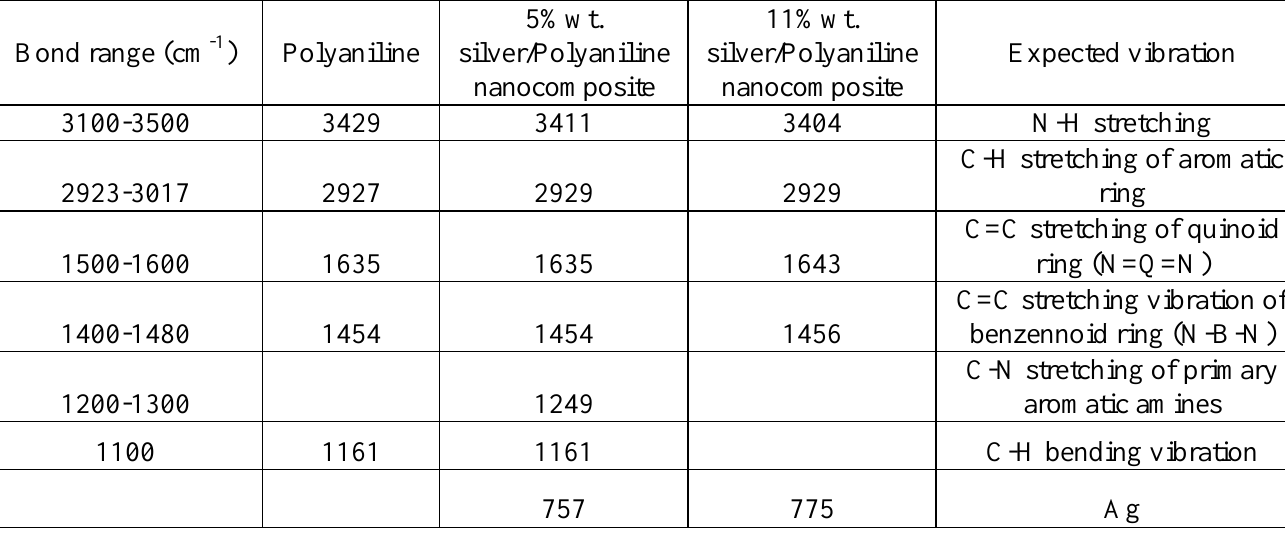
Table 1: FTIR common band for pure Polyaniline and different concentrations of Ag nanoparticles in PANI.